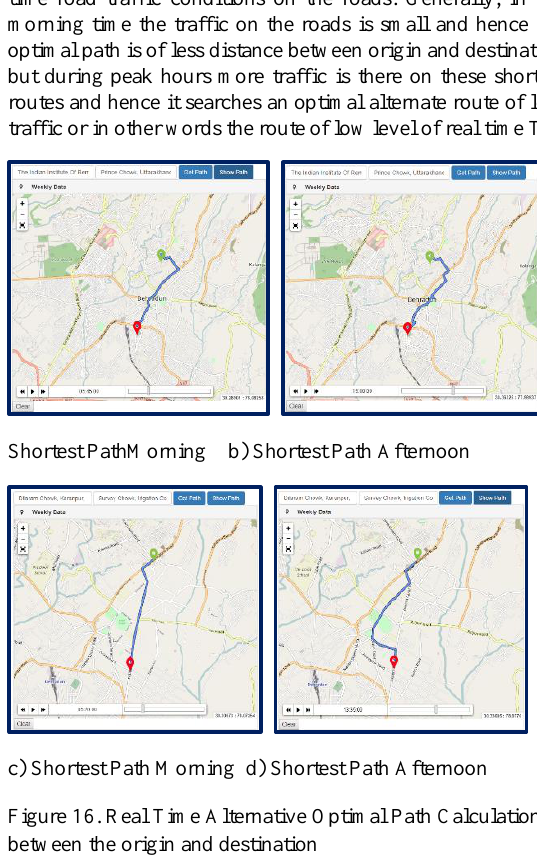
Figure 16. Real Time Alternative Optimal Path Calculation between the origin and